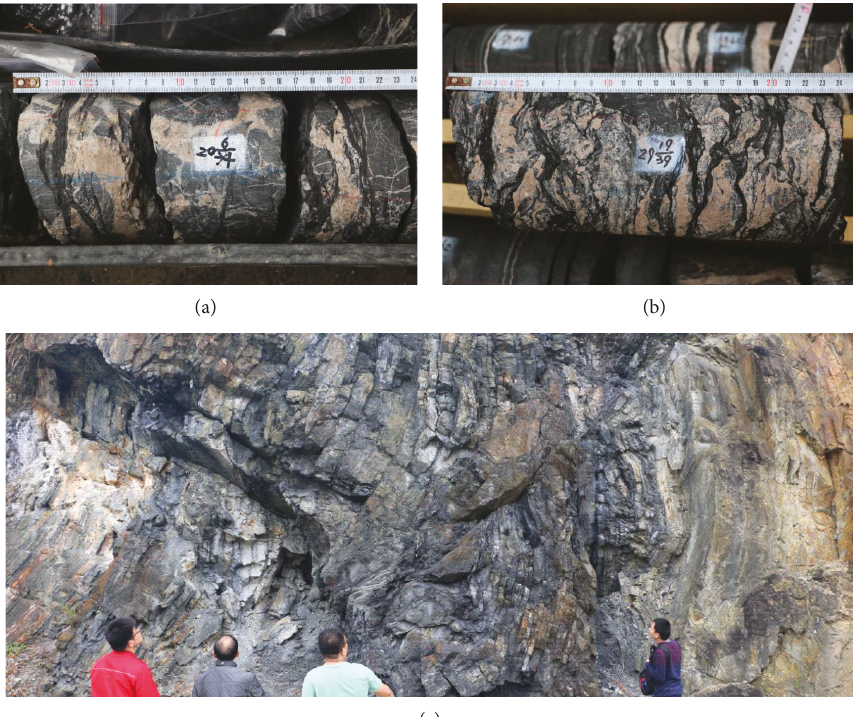
Figure 8: A detachment layer widely developed at the bottom of the lower Cambrian Wangyinpu formation shale in Xiuwu Basin. Core photos at the bottom of the lower Cambrian Wangyinpu formation: (a) in Jiangye-1 (depth: 2670 m) and (b) in Jiangye-2 (depth: 3135m). (c) A photo of Laozhuang Outcrop at the bottom of the lower Cambrian Wangyinpu formation. See Figure 1 for the well locations. Table 4: The sealing parameters of shale and its roof and fl oor in Jiangye-1 of the lower Cambrian Wangyinpu formation. The data of average TOC content and average porosity is referred to Liu et al. [24]. See Figure 1 for the well locations. Part Fm. Lith. Depth (m) Avg. TOC (%) Avg. porosity (%) Thk. (m)